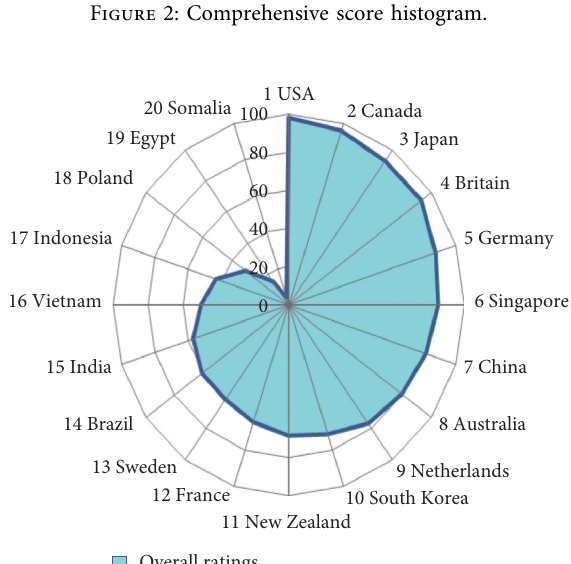
Figure 2: Comprehensive score histogram.